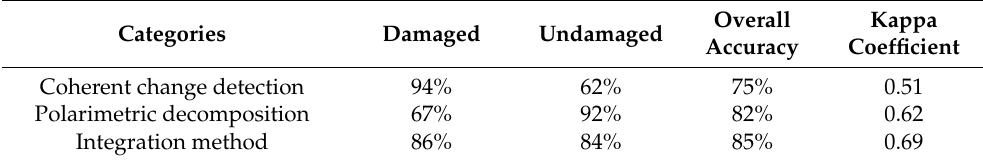
Table 5. The accuracy of the two different methods and the combined